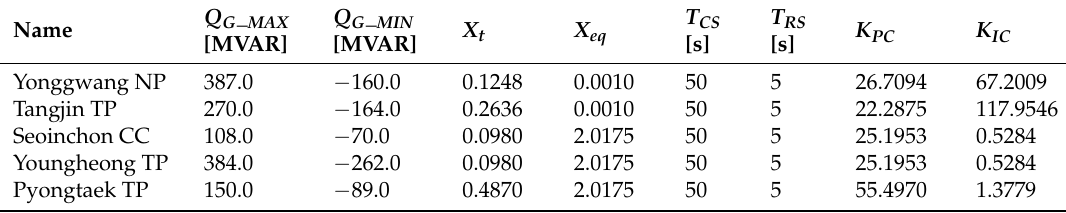
Table 1. Control parameters of the control generators in Korean power system.